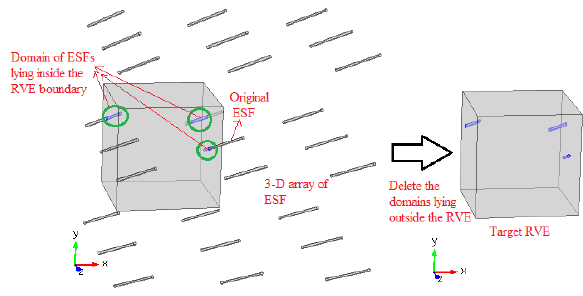
Fig. 4: Stepwise procedure to model the periodic RVE reinforced by